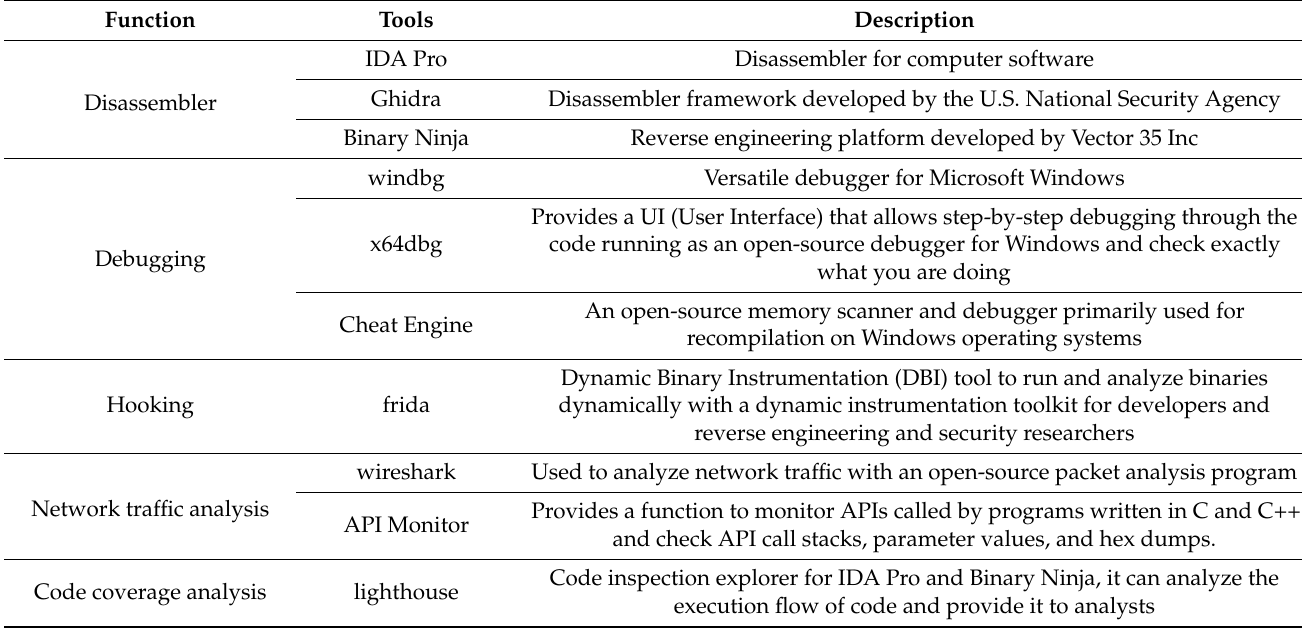
Table A2. List of tools used in the